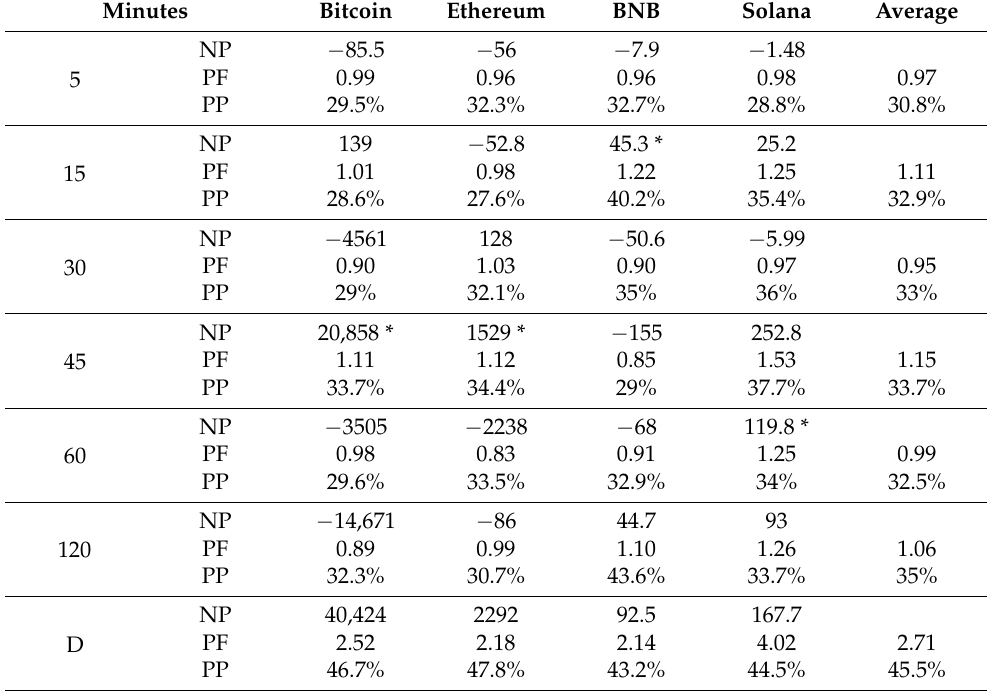
Table 5. Results of Ichimoku cloud plus CMF trading